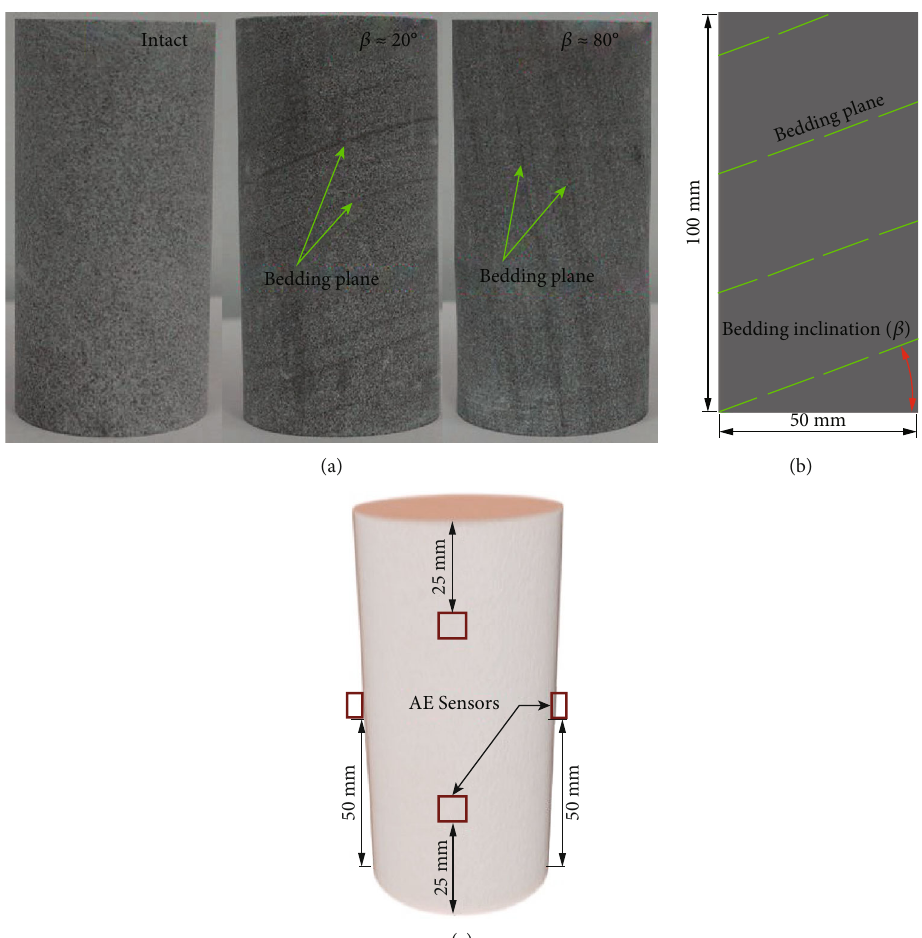
Figure 2: Diagram of selected samples: (a) material objects; (b) detailed geometries; (c) schematic of arrangement of AE sensors. The green dotted line represents the bedding plane of the